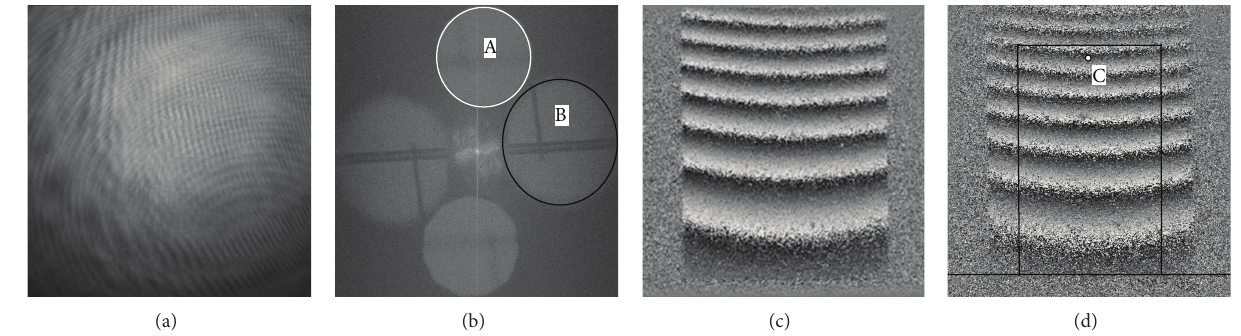
Figure 8: (a) Typical digital hologram obtained by illumination from two lasers; (b) spectrum of the digital hologram obtained; (c) typical original wrapped phase map with 𝜆 1 = 633 nm; (d) typical original wrapped phase map with 𝜆 2 = 523 nm, and the selected area to process (reprint from [62]).